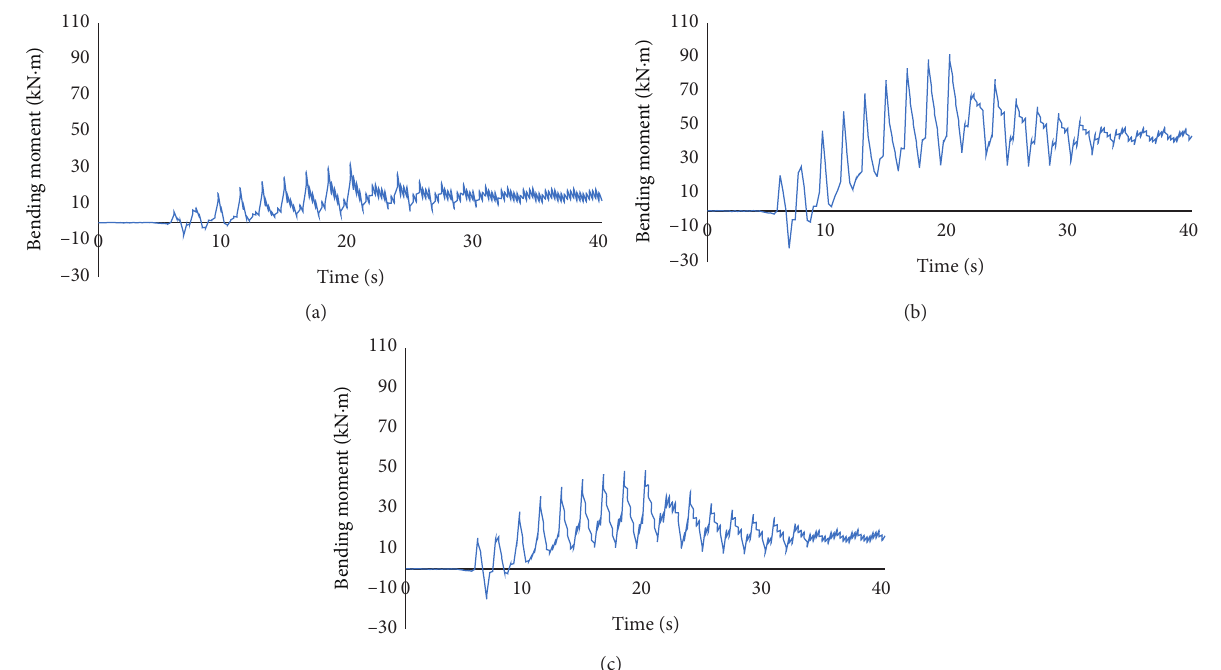
� 3 m, (b) D � 6m, and (c) 1 1